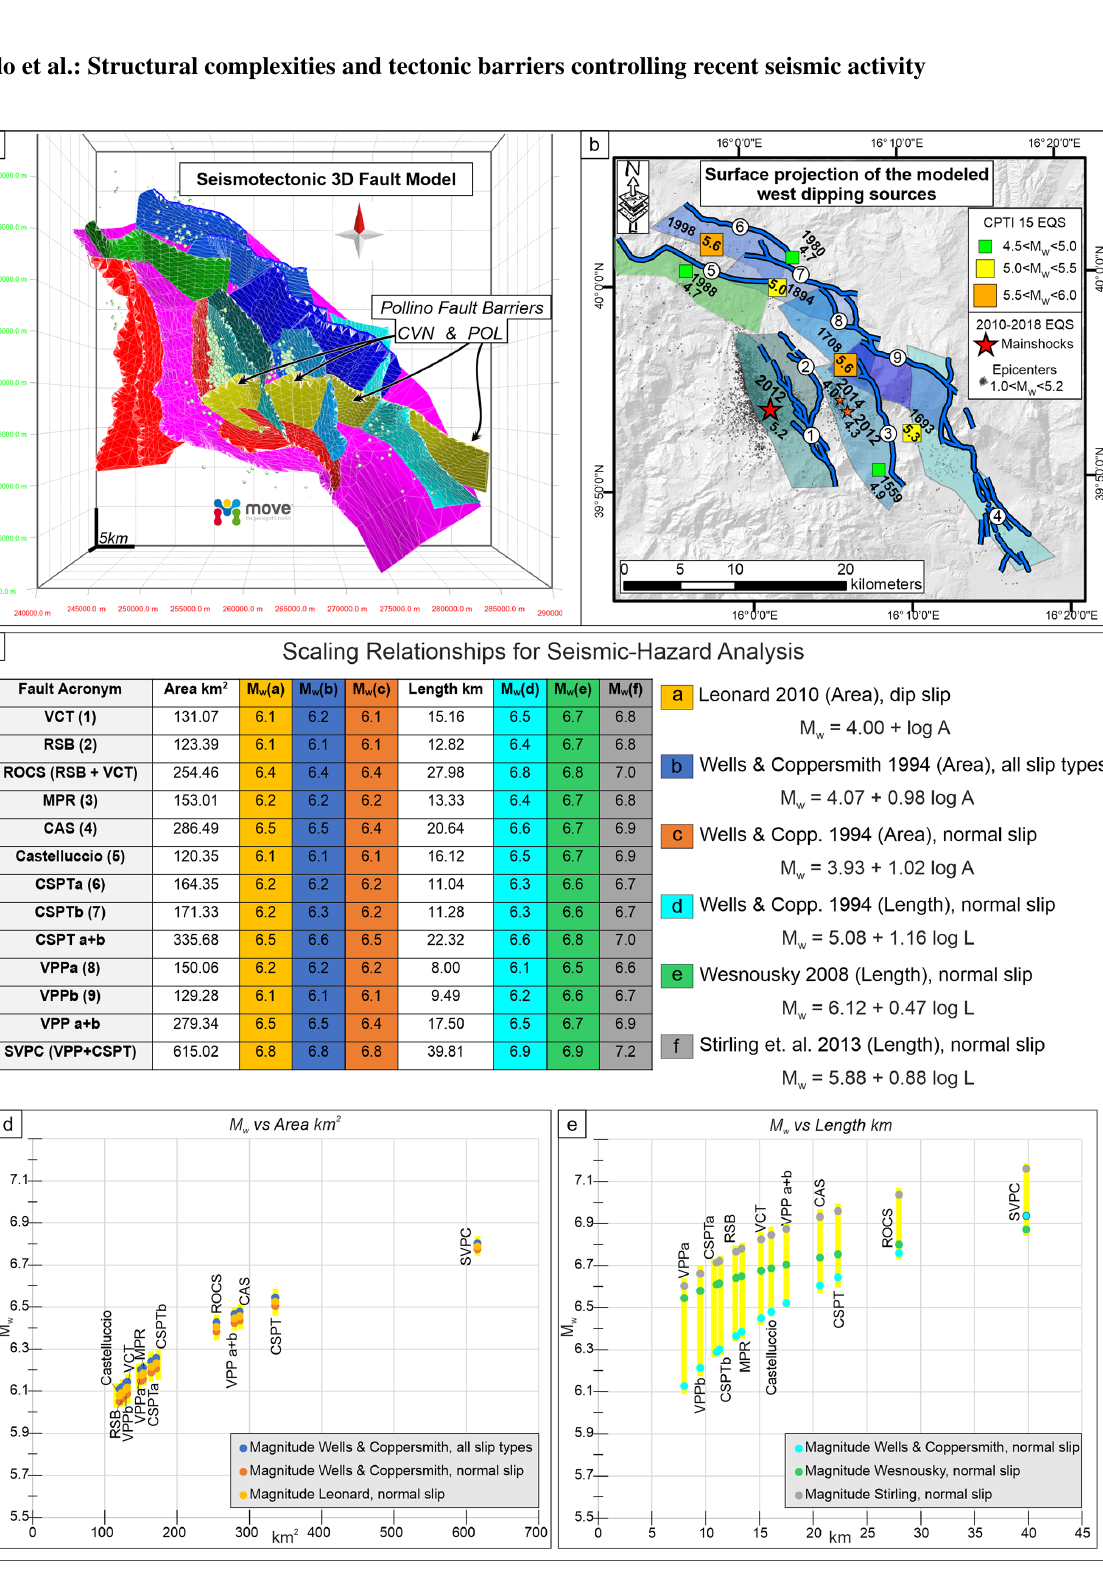
https://doi.org/10.5194/se-13-205-2022 Solid Earth, 13, 205–228,